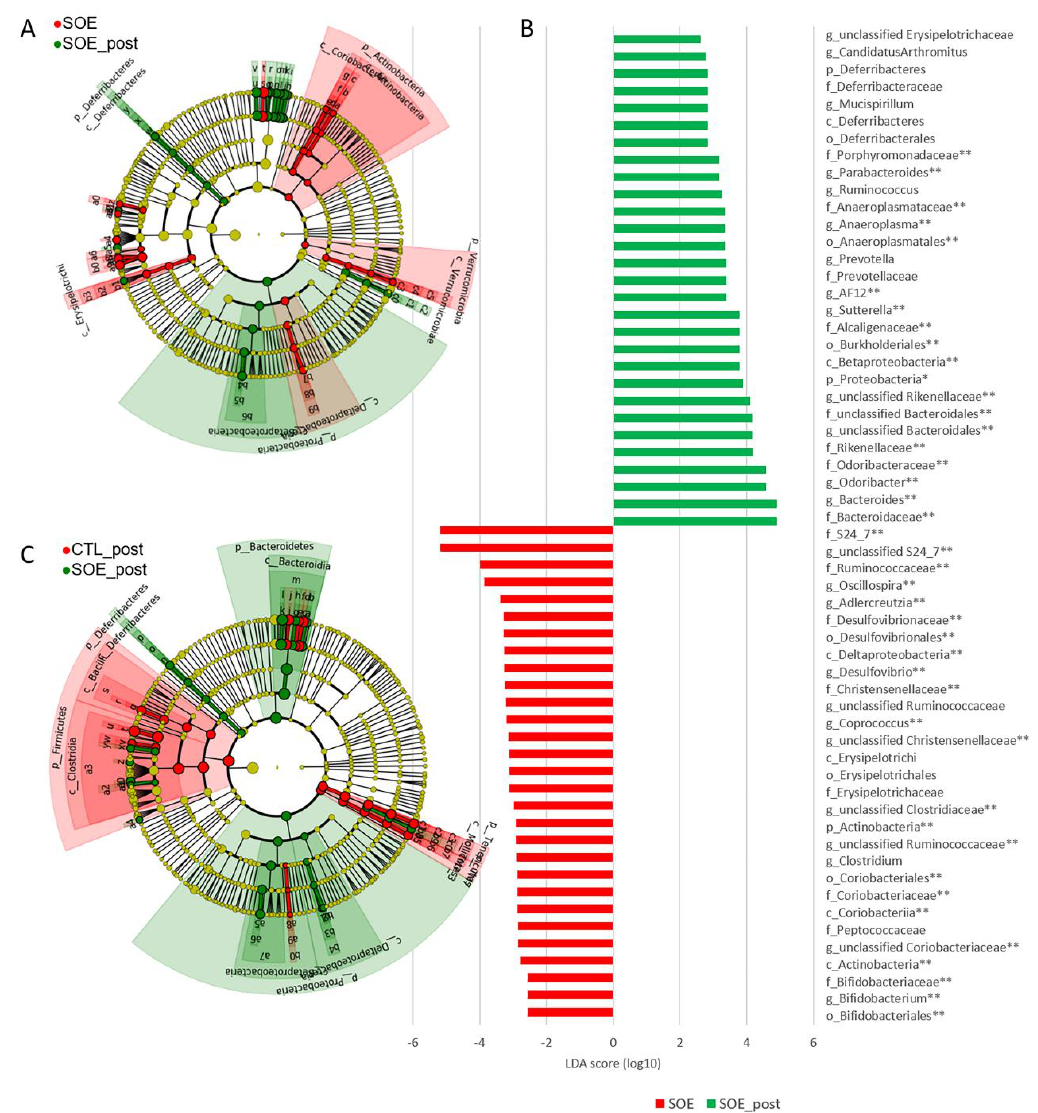
Figure 2. Di ff erently abundant taxa of control and SOE treated mice. Bacterial composition was assessed by Illumina MiSeq 16S rRNA gene sequencing of fecal DNA. ( A ) Cladogram representation and ( B ) linear discriminant analysis (LDA) scores of di ff erentially-abundant taxa between SOE supplemented mice preceding (red; 8 weeks of age) and following (green; 12 weeks of age) the study period. ( C ) Cladogram representation of di ff erentially-abundant taxa between control (red) and SOE (green) supplemented mice following the study period (12 weeks of age). Di ff erences were identified using LefSe and displayed in color. Each circle (cid:48) s diameter is proportional to the taxa relative abundance. Only taxa meeting LDA ≥ 2.5 and p < 0.05 are shown. * p < 0.01, ** p <